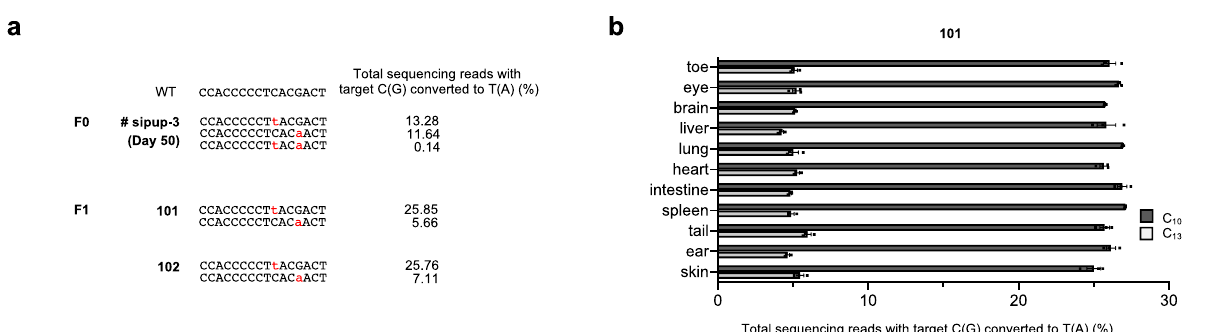
Fig. 3 Germline transmission of mutant mtDNA. a To observe the germline transmission of mtDNA mutations, the female F 0 (sipup-3) mouse was crossed with a wild-type C57BL6/J male to obtain F 1 pups (101, 102), after which targeted deep sequencing was performed. Edited bases are shown in red. Editing frequencies in the mutant mitochondrial genome are shown. b Base editing ef fi ciencies in various tissues from an F 1 newborn pup (101), obtained using targeted deep sequencing of genomic DNA. Dark and light gray bars represent the frequency of m.C12539T (C 10 ) and m.G12542A (C 13 ) mutations, respectively. Error bars are the standard error of the mean (s.e.m.) for n = 3 biologically independent samples. Source data are provided in the Source data fi le.